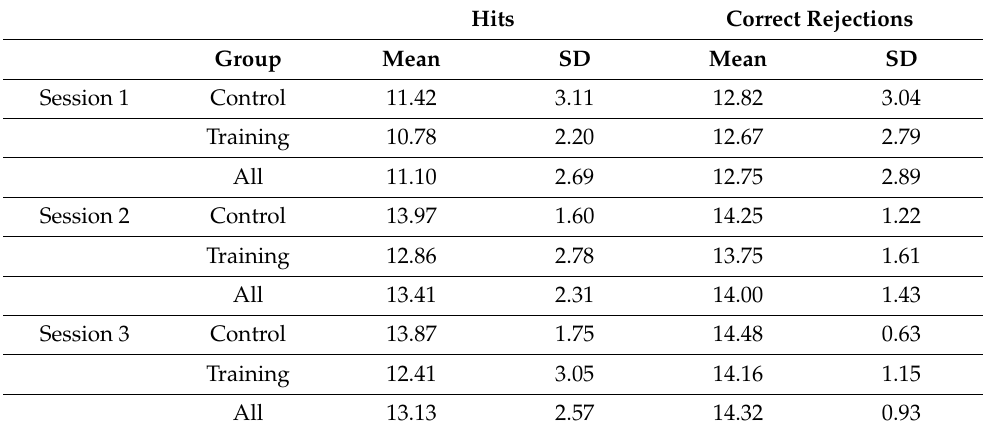
Table 1. Descriptive statistics concerning the N-back task. The number of hits (max = 16) and correct rejection of lures (max = 15) for two groups and three scanning